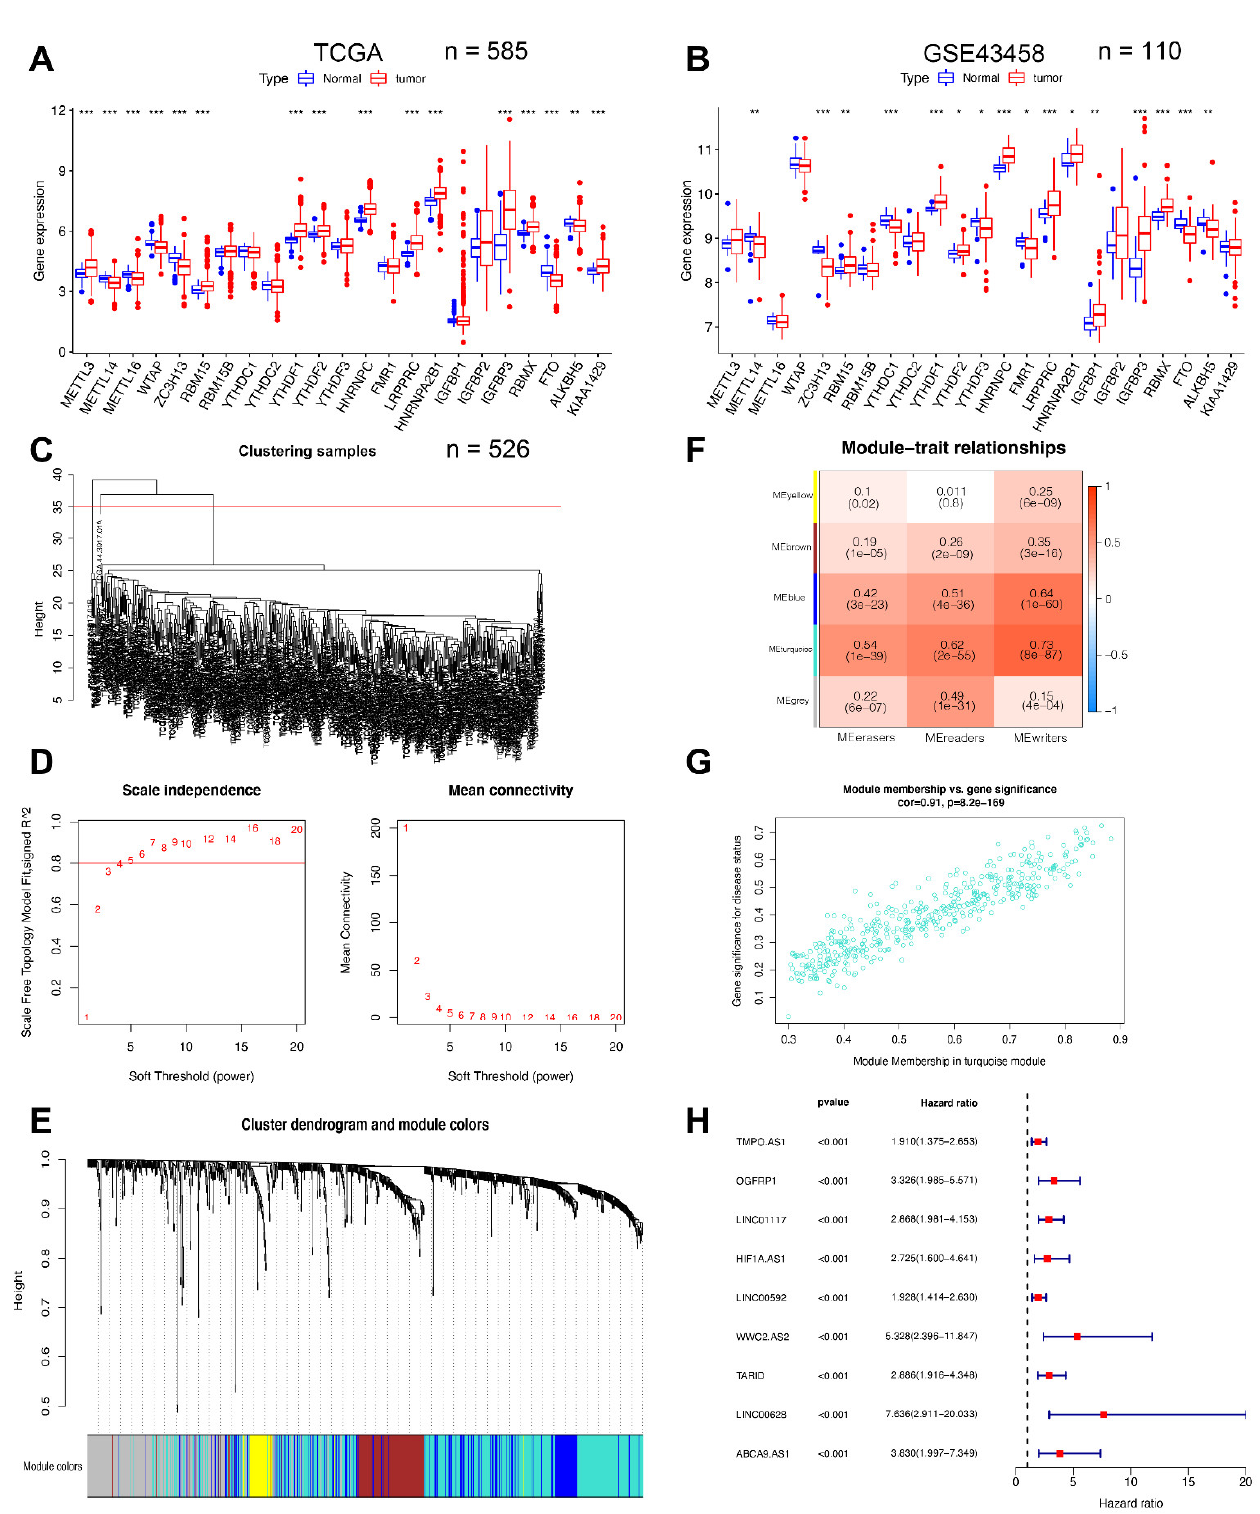
Figure 1. Identification of 9 lncRNAs associated with m6A regulators in the TCGA-LUAD cohort. Expression levels of m6A RNA methylation regulators between LUAD and adjacent normal tissues in ( A ) TCGA-LUAD ( n = 585) and ( B ) GSE43458 ( n = 110); ( C ) Clustering dendrogram of samples ( n = 526) to detect outliers; ( D ) Scale independence and the mean connectivity of the WGCNA samples; ( E ) Dendrogram of all lncRNAs clustered with dissimilarity measure based on topological overlap; ( F ) Heatmap of the correlation between modules and m6A regulators. Each cell contains the correlation coefficient and P-value; ( G ) Scatter plot of lncRNAs in turquoise module; ( H ) Univariate Cox regression analysis for 9 lncRNAs from the turquoise module. * P < 0.05, ** P < 0.01, *** P < 0.001.